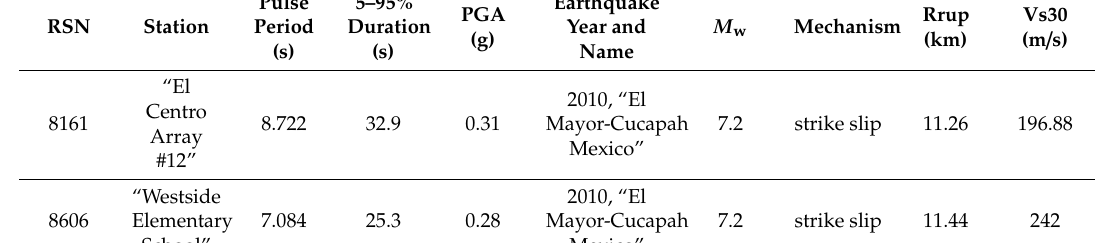
Table 1. Basic features of the two selected records from the PEER Ground Motion Database [49].